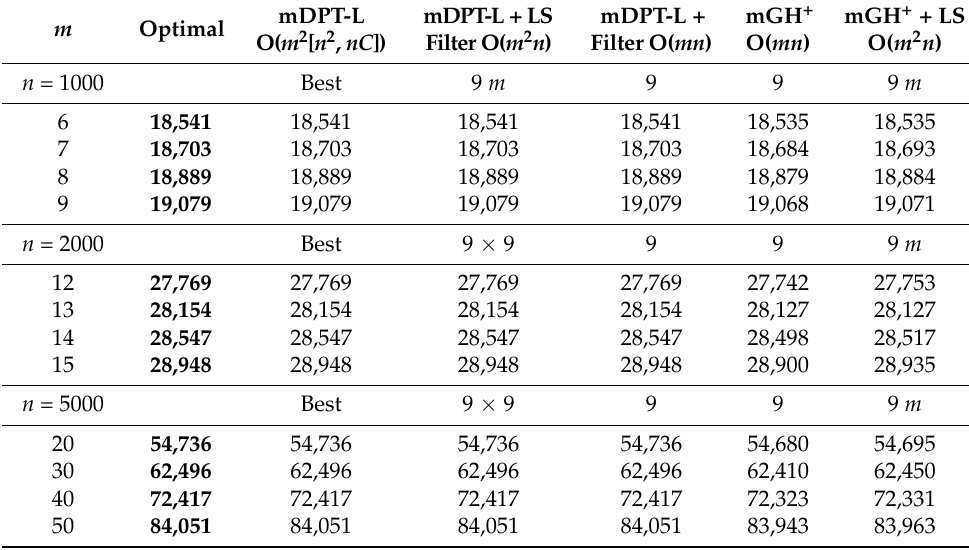
Table 8. Results (total profits) of datasets ( C ± 20), n = 1000–5000 ( m =